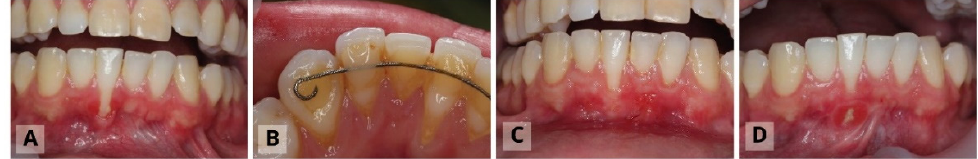
Figure 2. Second protocol—without bonded lingual retainer (BLR) removal. Patient number three— 27-year-old male arrived with Miller Class III recessions both on the buccal and the lingual surfaces of tooth #41. Eight years passed since orthodontic treatment completion and lingual fixed retainer was maintained. Lingual retainer was not removed prior to surgery ( A , B ). One month after surgery a gingival recession of 3 mm was present ( C ). Six months follow up after surgical procedure, note the gingival fenestration ( D ).